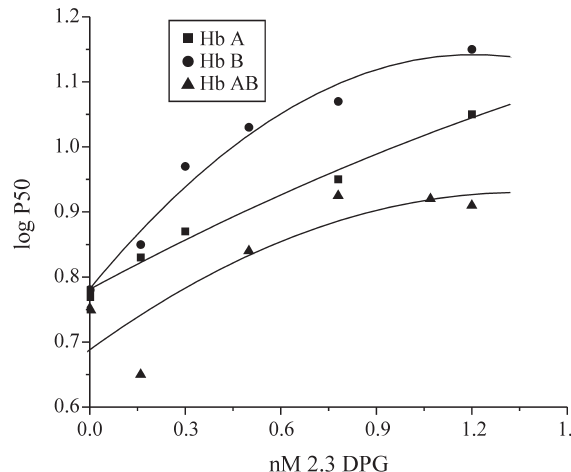
Figure 4 - Influence of the concentration of 2,3DPG on the P50, pH 6,9.